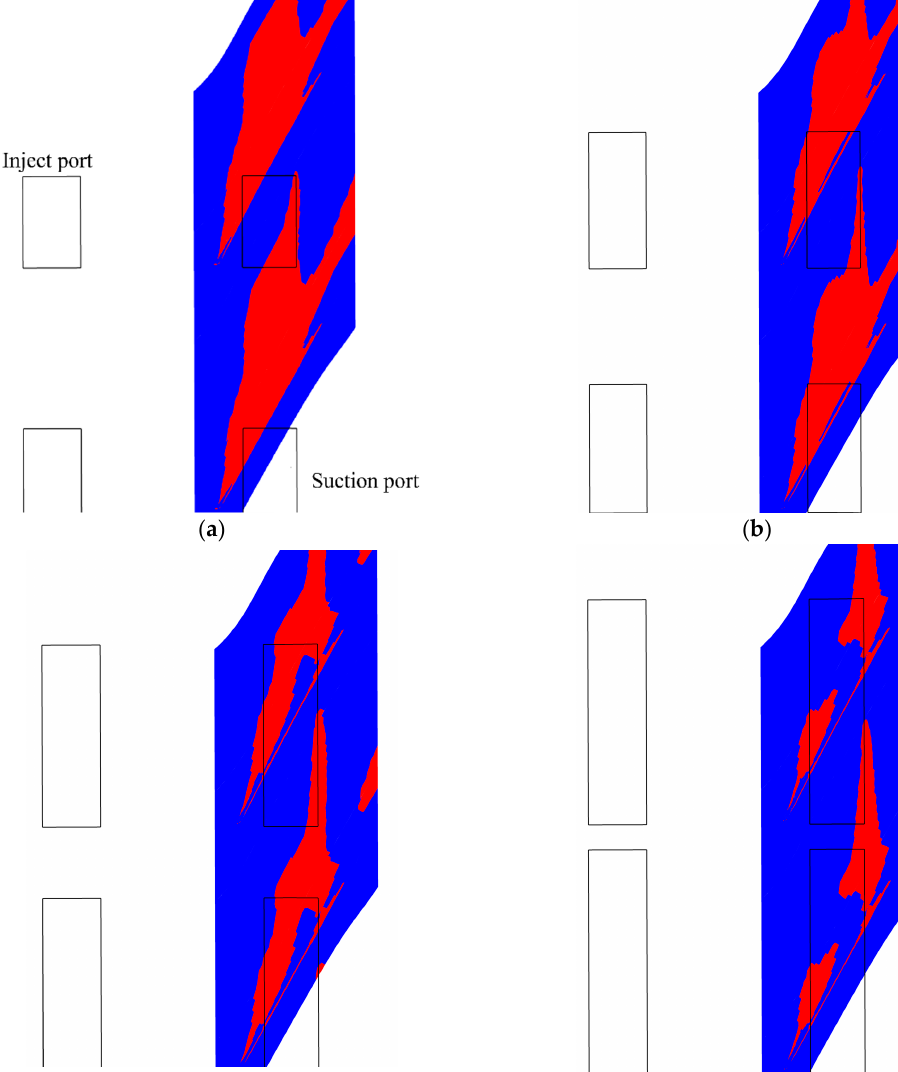
Figure 20. Changes in the blockage ratio under different self-circulating casings at 50% τ .